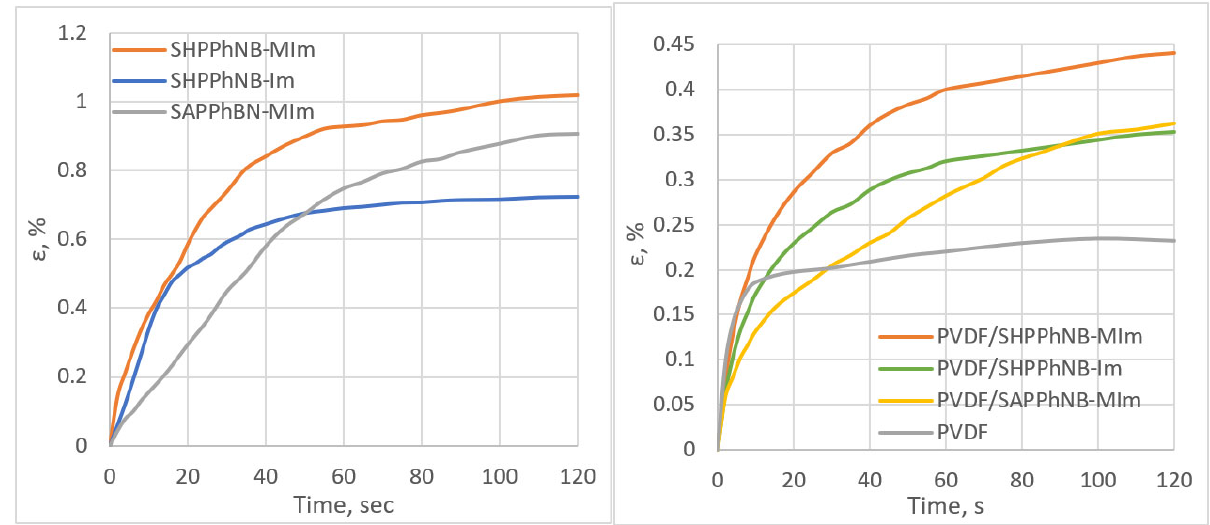
Figure 5. Diagram of time dependence of generated strain of the actuators under 2V DC. The maximum strain at different voltage for all actuators are collected in Table 5. Max-